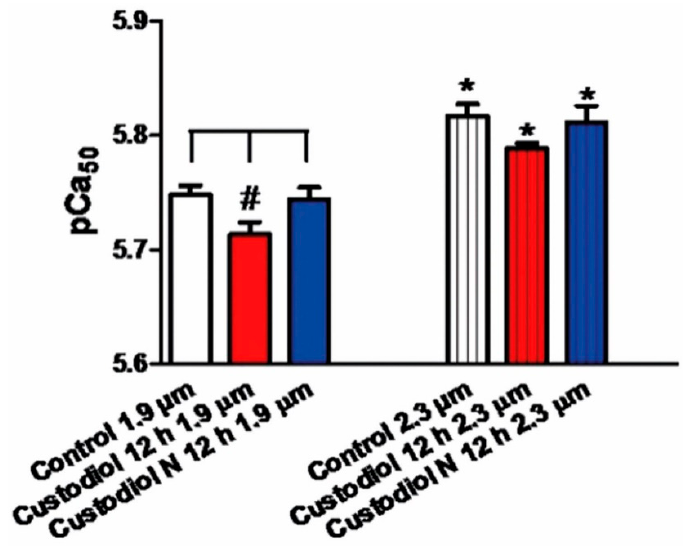
Figure 5. In vitro force measurements. The calcium-sensitivity index pCa50 of isolated cardiomyocytes, at 1.9 and 2.3 µ m sarcomere lengths, from native control hearts and transplanted hearts from the Custodiol and Custodiol-N groups after 12 h of ischemic conservation. Columns represent the mean ± SEM of 5–17 experiments in the different groups. * p < 0.05 vs. 1.9 µ m, # p < 0.05 vs. as depicted.